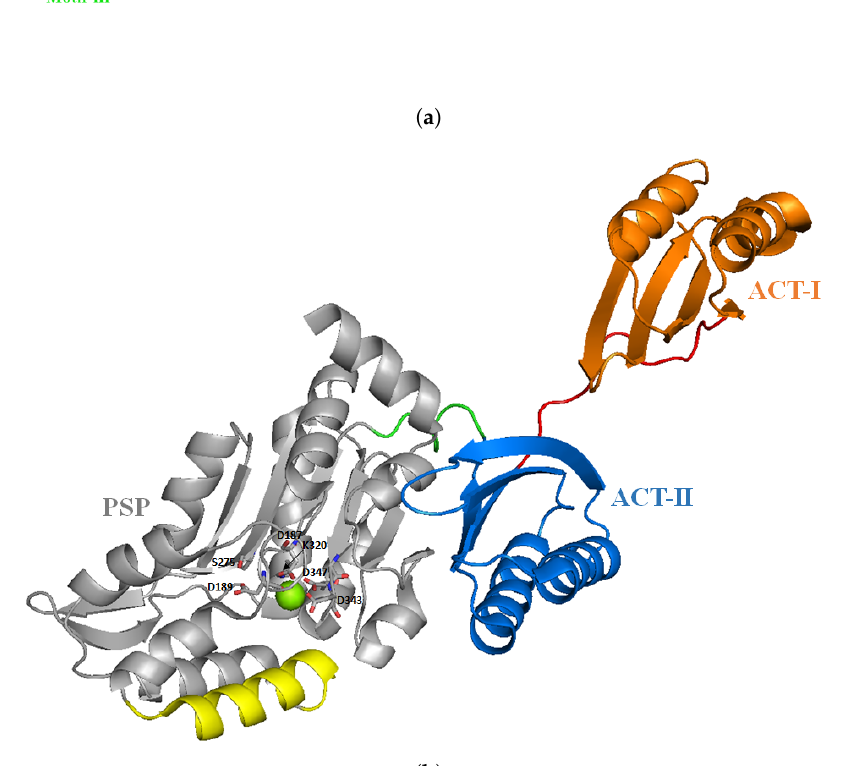
Figure 11. Similarity between phosphoserine phosphatases from Mycobacterium tuberculosis (Mt), avium (Ma) and leprae (Ml) ( a ). Red color in the sequence means that residues are strongly conserved. Orange frame shows residues constituting the ACT-I domain, blue the ACT-II, grey the PSP domain and yellow the CAP domain closing the active site. Green frames represent the highly conserved residues among PSP from various organisms (human, mammals, etc.). Structure of M. avium (3P96) with domain ACT-I in orange, ACT-II in blue, the linker between two ACT domains in red, PSP catalytic domain in grey, linker between PSP domain and ACT-II in green ( b ). The magnesium within catalytic core is in green and the highly conserved residues stabilizing it are highlighted. The α helix cap closing the active site is in